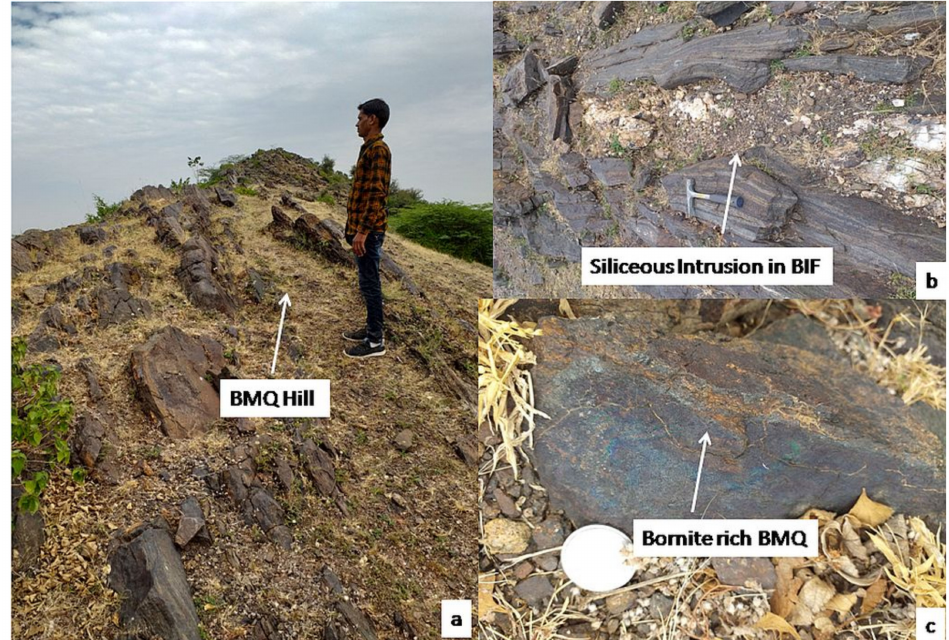
Figure 13. ( a ) The BMQ hill extending along NE-SW, near Devpura village (see Figure 12 as the reference). ( b ) The late phase silica intrusions are often associated with mineralization (Cu-sulfide) and is also identified within BMQ. See Figure 12b for further reference ( c ) The surface indications in the form of bornite stains within BMQ, at Devpura village.